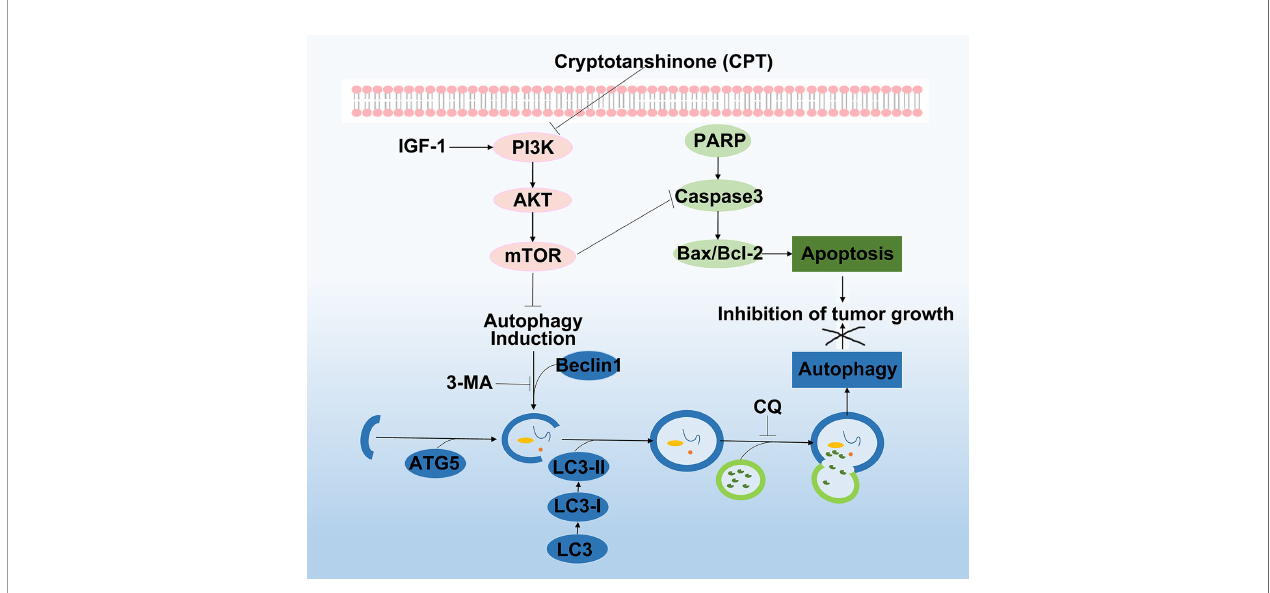
TABLE S2 | List of HCC-related targets. TABLE S3 | List of the common targets of CPT and HCC. TABLE S4 | List of the 32 hub targets in this PPI network. TABLE S5 | Functional classi fi cation of the common targets based on DAVID analysis. TABLE S6 | Pathway enrichment results based on the common targets of CPT and